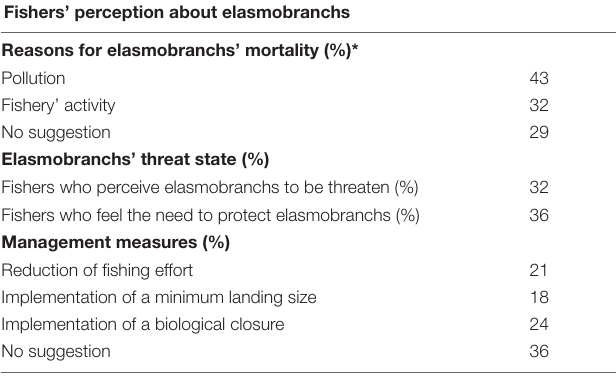
TABLE 1 | Fishers’ perception about the reasons for elasmobranch mortality, threatening state, need of protection and suggested management measures to protect